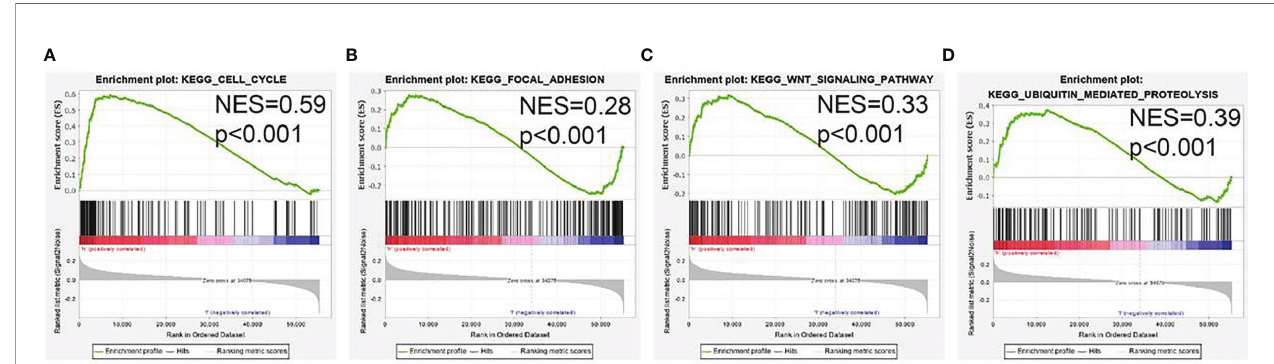
FIGURE 5 | GSEA Identi fi cation of AL139385.1-related signaling pathways. (A – D) Identi fi cation of AL139385.1-related signaling pathways by